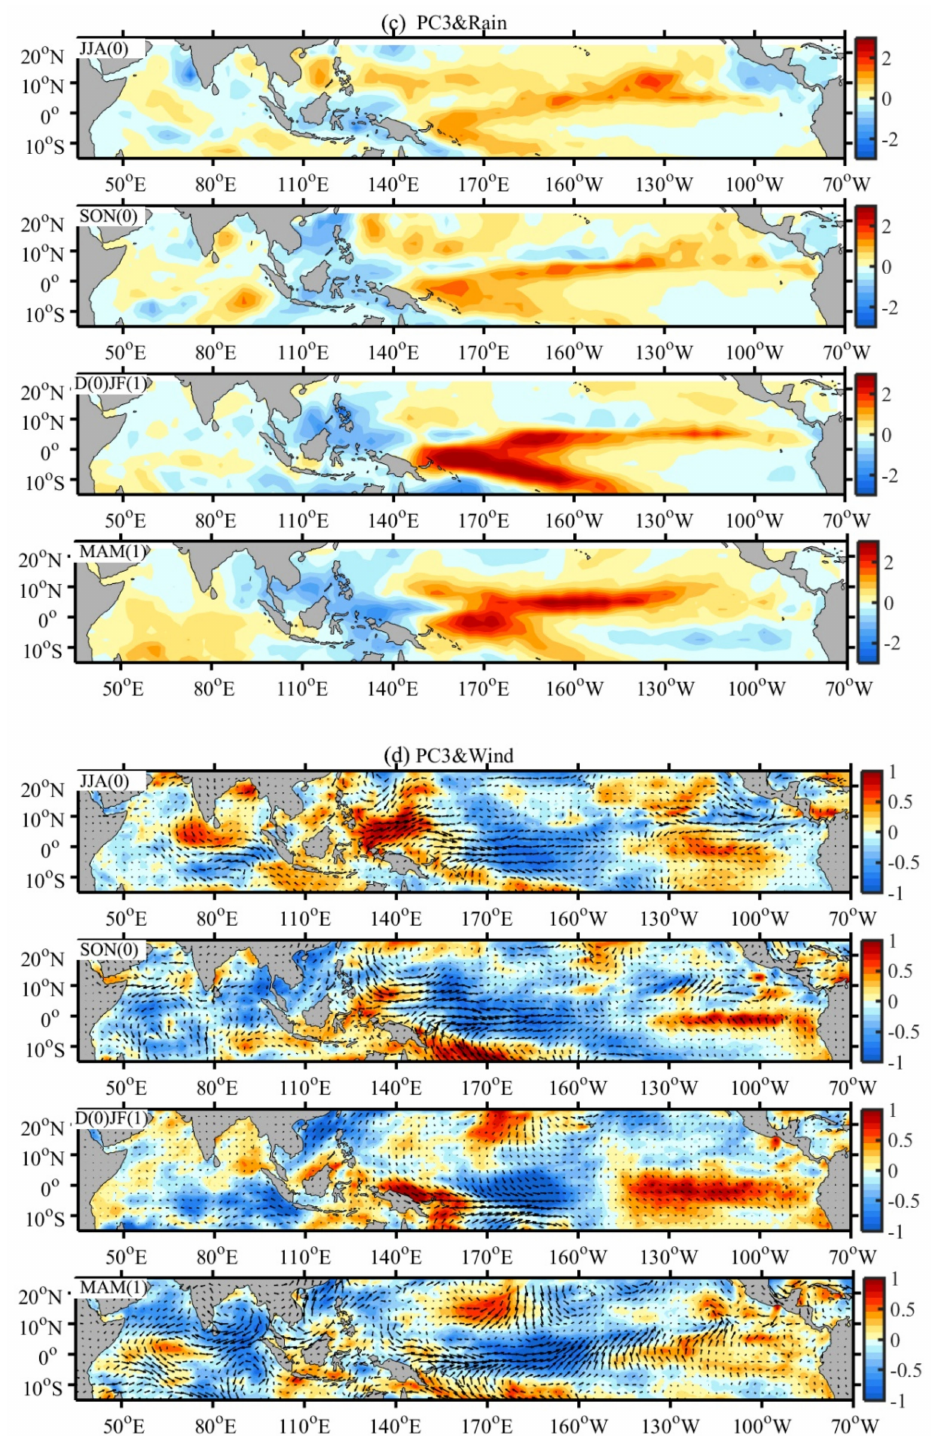
Figure 9. The same as in Figure 7, but with S-EOF3 synchronously. In the Indian Ocean area, in the boreal summer and fall, the western equatorial Indian Ocean heating appears to be consistent with that of the eastern equatorial Pacific. The southeastern Indian Ocean sea surface temperature negative anomaly, for the typical Indian Ocean IOD mode, is a response to ENSO events in the Indian Ocean, and its mechanism is the impact of the middle eastern tropical Pacific on the Indian Ocean sea surface heat flux through the “bridge” atmosphere [21]. The sea surface height is also shown as